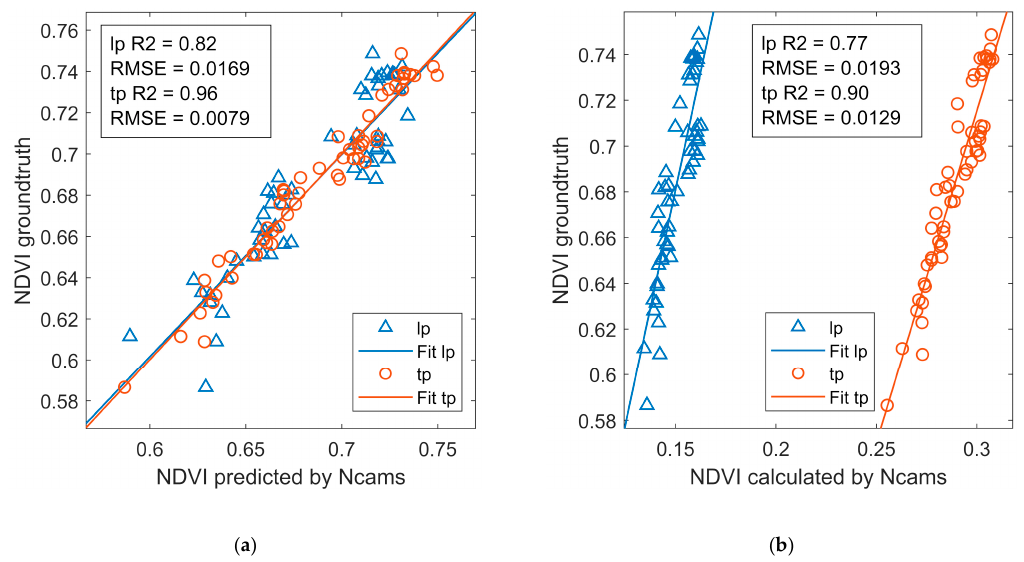
Figure 7. The performances of Ncams on estimating NDVI with ( a ) machine learning methods and ( b ) typical formula. lp, Ncam lp; tp, Ncam tp.